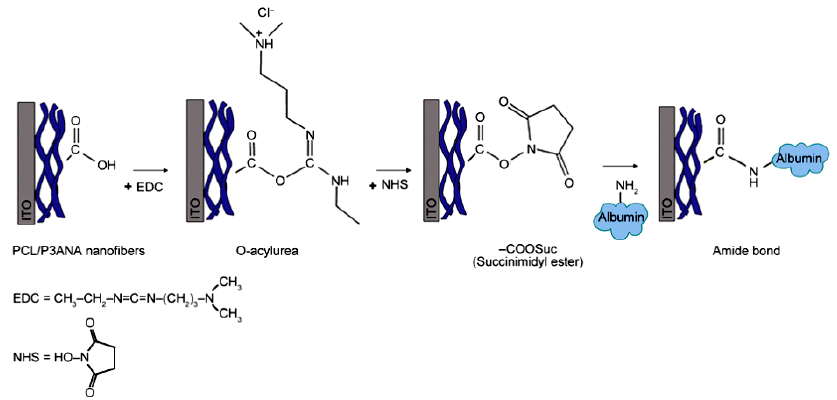
Figure 7. Schematic representation of the covalent attachment of albumin protein on electrospun nanofibers through EDC / NHS activation. EDC / NHS enables proteins to be easily conjugated to a substrate with carboxyl or amino groups (Reproduced with permission from [45]. Copyright Express Polymer Letters, 2016.